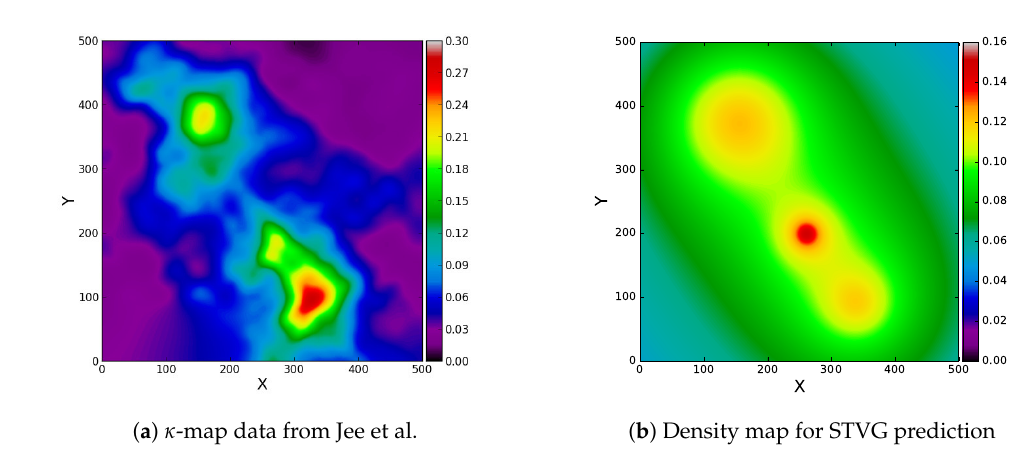
Figure 7. A520 κ -map. The first plot is the data, whereas the second plot is the STVG (MOG) prediction.